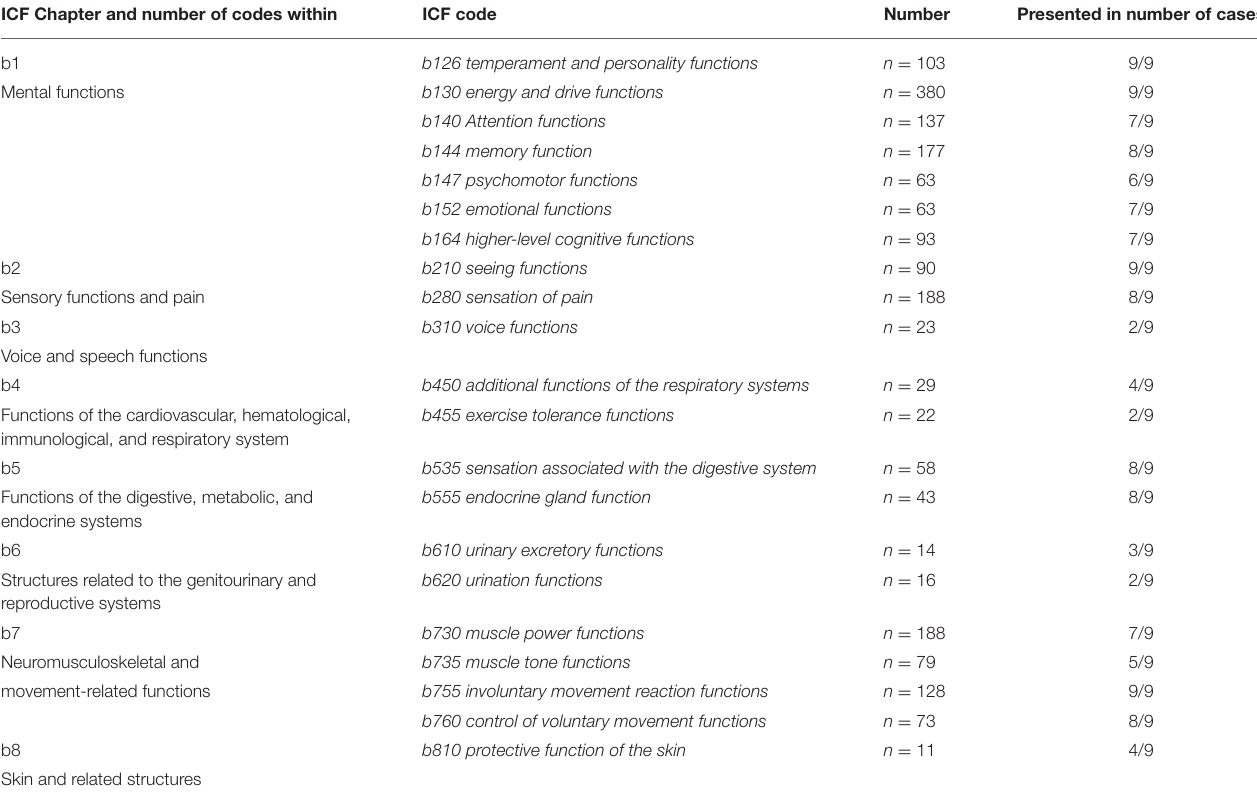
TABLE 3 | Examples of most frequently used ICF codes within the chapters of Body function